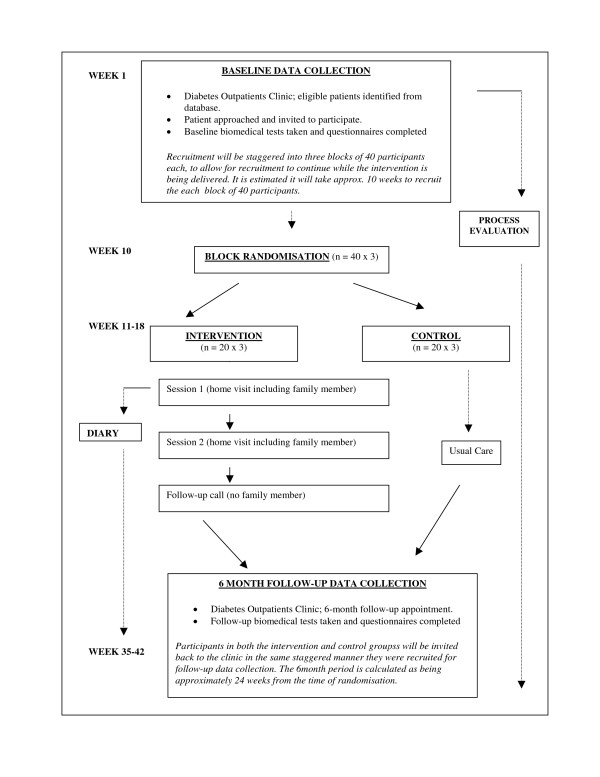
Flow Chart of RCT.